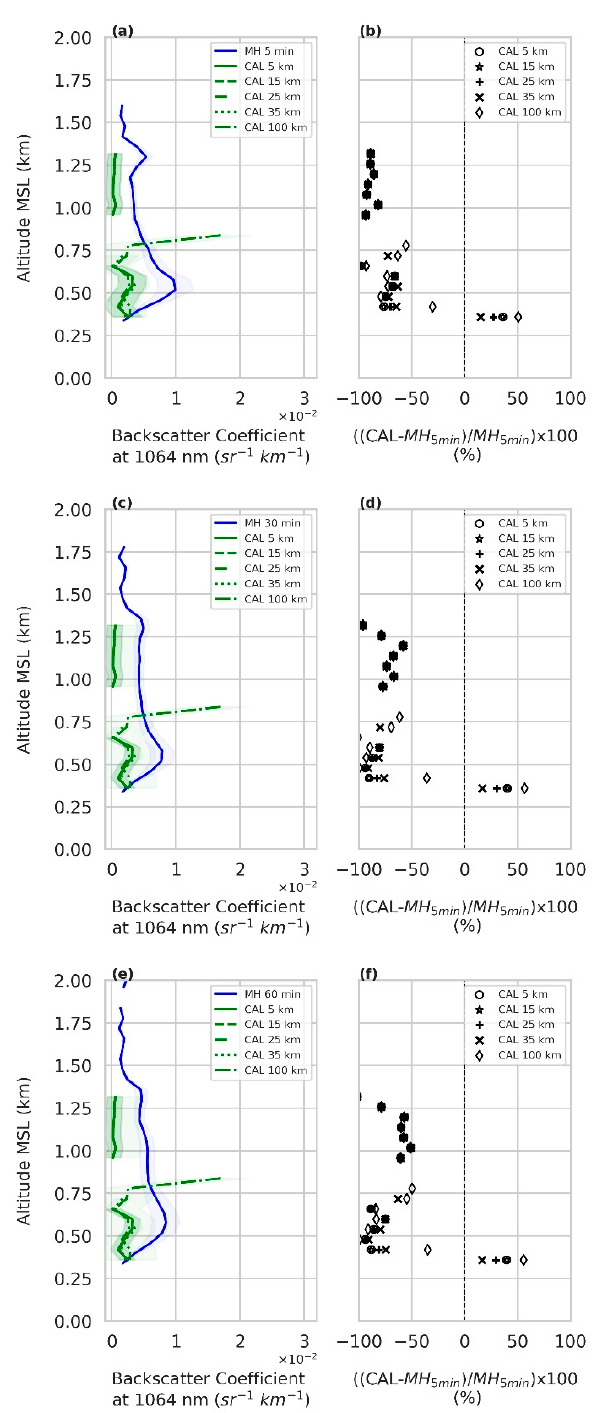
Figure A1. Backscatter Coefficient at 1064 nm profiles and the corresponding mean percentage difference as a function of altitude m.s.l for a CALIOP overpass at Mace Head on 18 November 2014 (cloud–free case) at 13:41:22 UTC at 29.56 km distance from Mace Head. The comparison uses CALIOP 5 km, 15 km, 25 km, 35 km, and 100 km along–track averages (1, 3, 5, 7, and 20 vertical profiles) and different temporal resolutions calculated for Mace Head data ( a , b ) 5 min (1 vertical profile) ( c , d ) 30 min (6 vertical profiles) and ( e , f ) 60 min (12 vertical profiles). The shaded areas represent the standard deviation of the measurements.